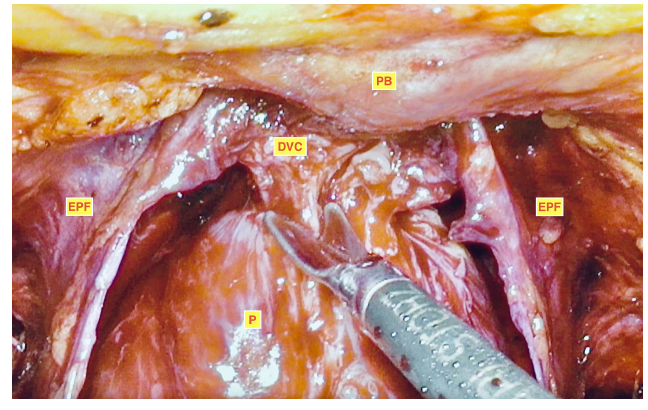
Figure 1. Preservation technique. The dorsal vascular complex (DVC) is transected with no previous ligation. There are no lateral incisions to the endopelvic fascia (EPF). P, prostate; PB, pubic bone.